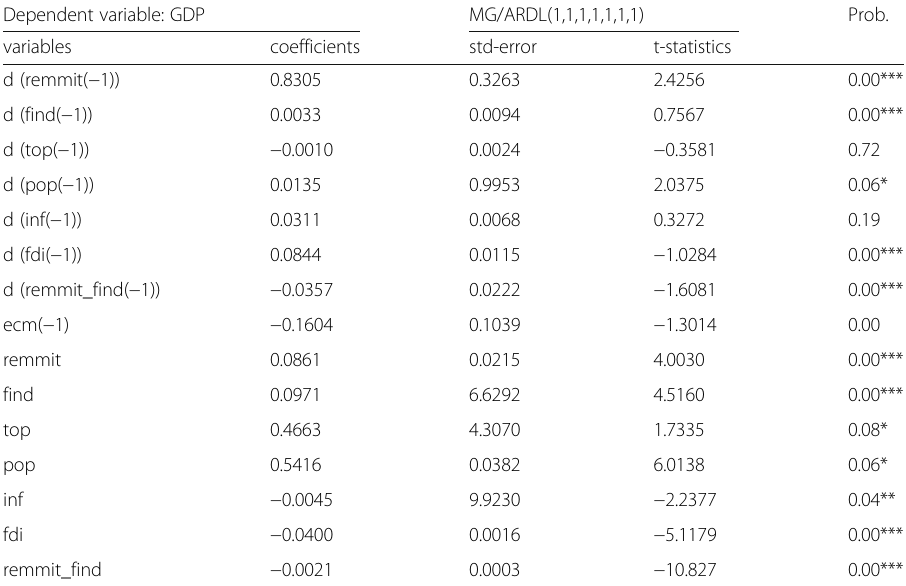
Table 11 The short and long run Mean Group/ARDL results